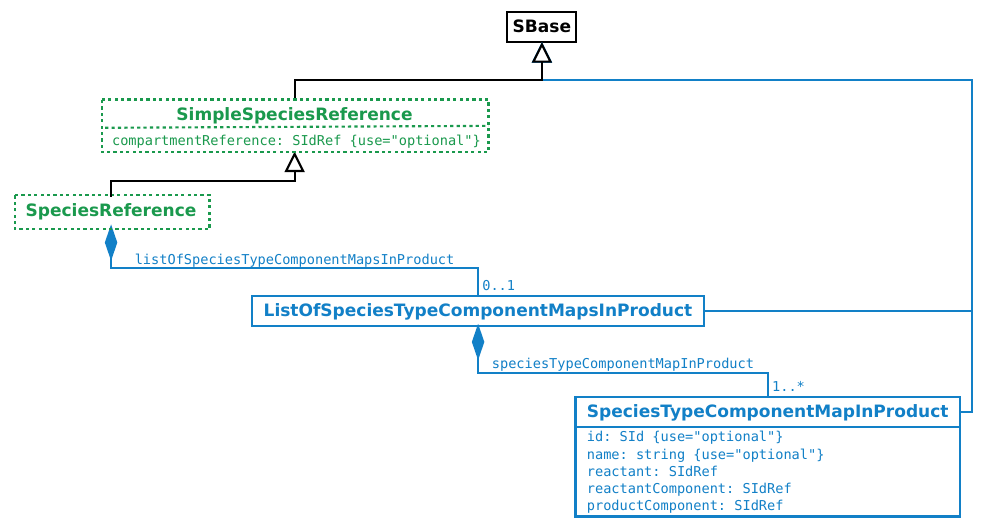
Figure 16: The extension of the SpeciesReference